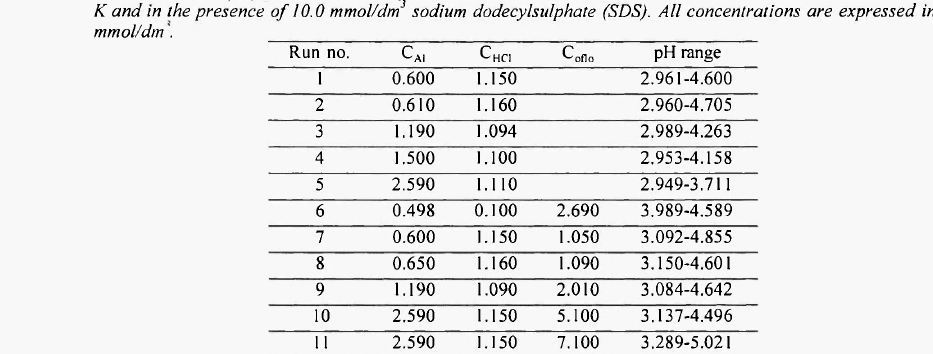
Table 1. Summary of Potentiometrie experimental results obtained in 0.1 mol/dm LiCl ionic medium at 298 Κ and in the presence of 10.0 mmol/dm 3 sodium dodecylsulphate (SDS'). All concentrations are expressed in mmol/drn .